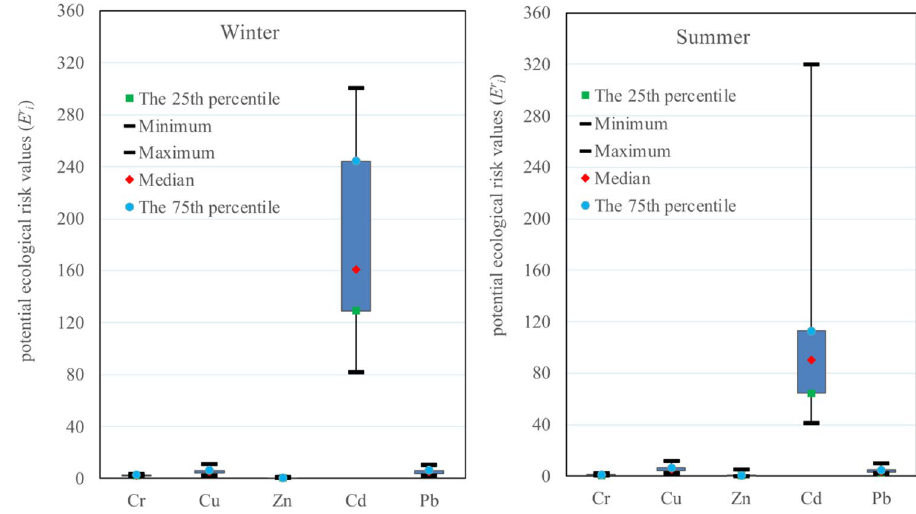
Fig. 5 Ecological risk index of heavy metals in the surface